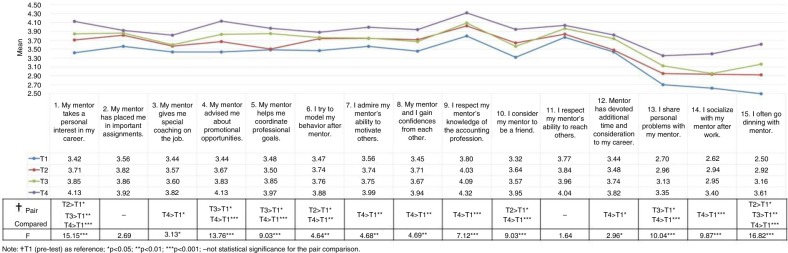
Four-wave mentoring evaluations.